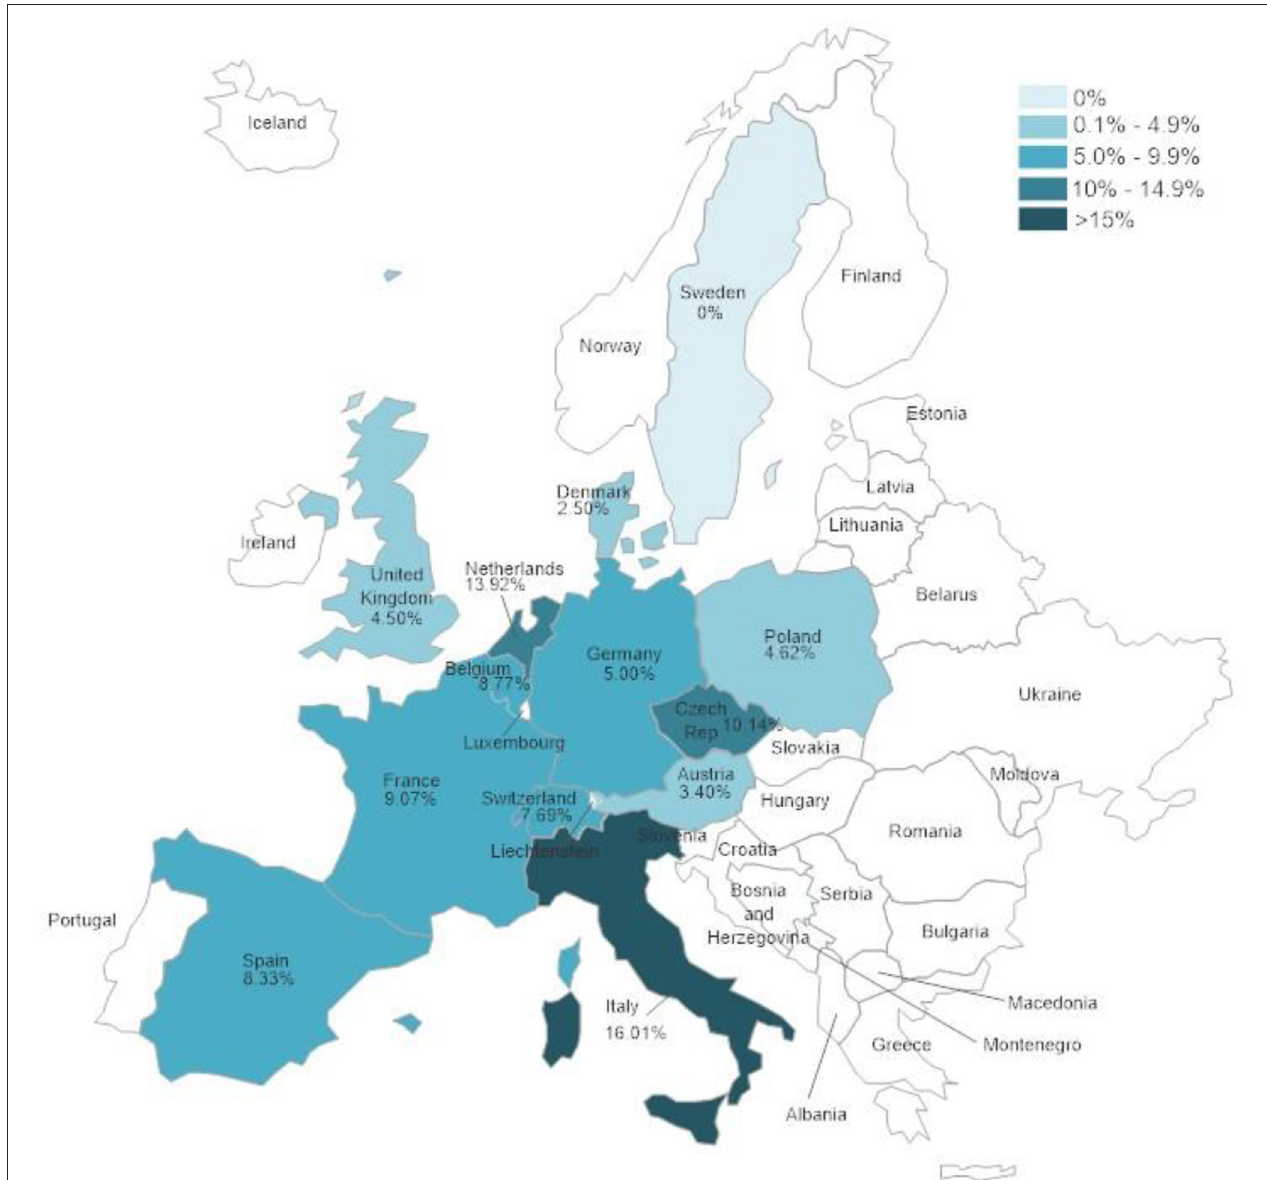
FIGURE 1 | Herpesvirus positivity rates according to country in which samples were collected. Only countries from which 50 samples or more were submitted were included in the